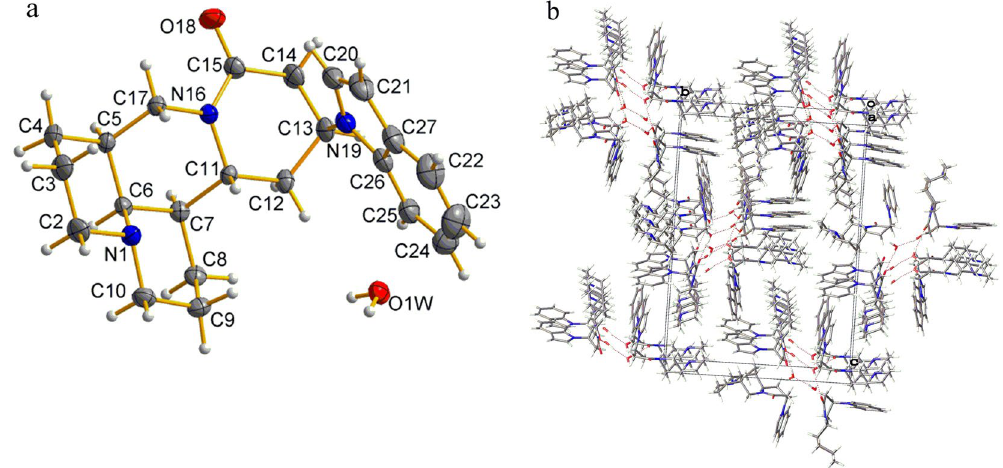
Figure 5. Crystal structure of matrine derivative 1 ( a ) and packing of its molecule in a unit cell ( b ).